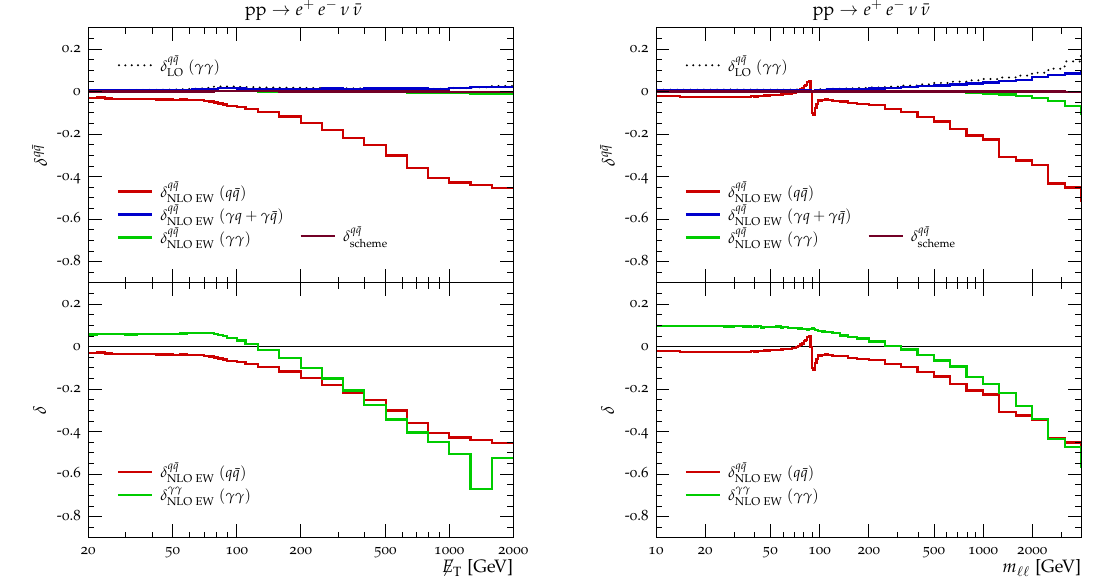
Figure 26 . Relative corrections in the missing transverse momentum, of the e + (cid:22) (cid:0) pair, m ‘‘ , for pp